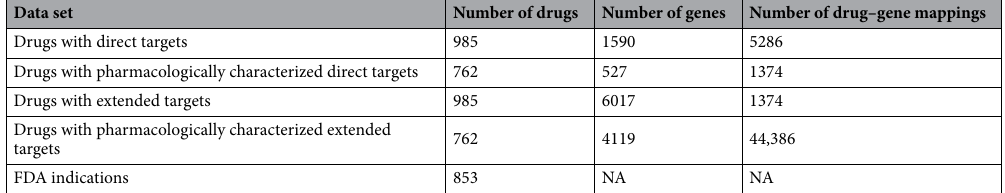
Table 1. Drug–gene targets data sets. FDA indications only connect drugs to diseases, not to